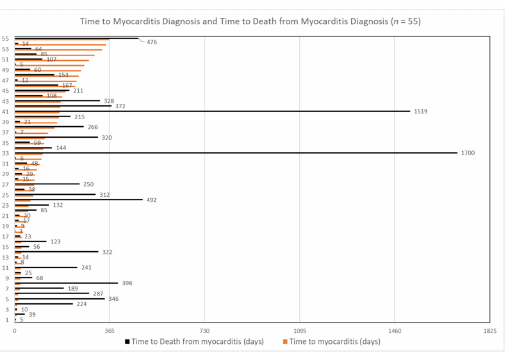
Figure 4. Time to myocarditis diagnosis and time to death from myocarditis diagnosis in patients who developed myocarditis and died during the study period ( n =